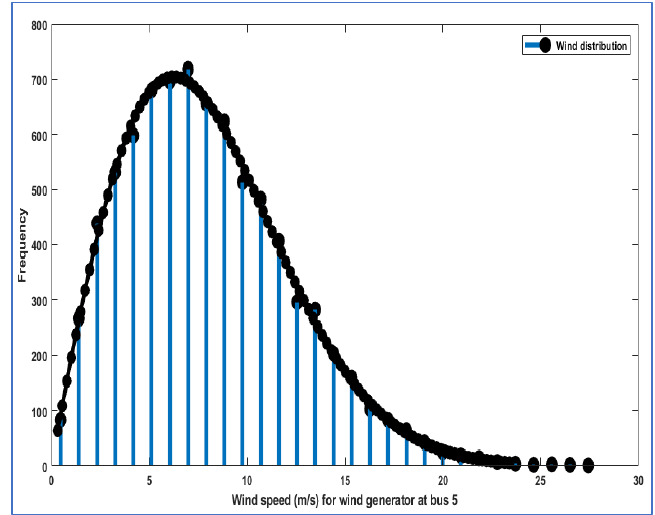
Figure 2. Weibull PDF (bus 5).